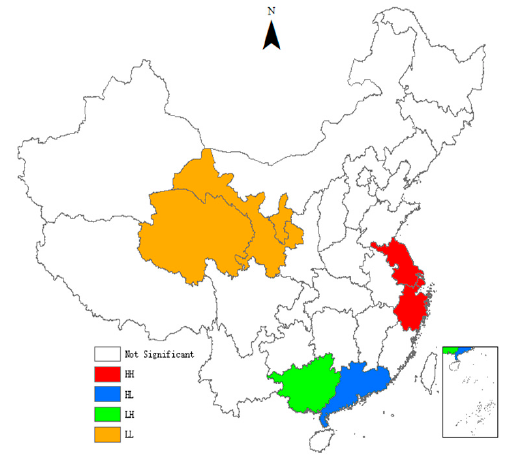
Figure 1. LISA agglomeration between 2000 and 2001.